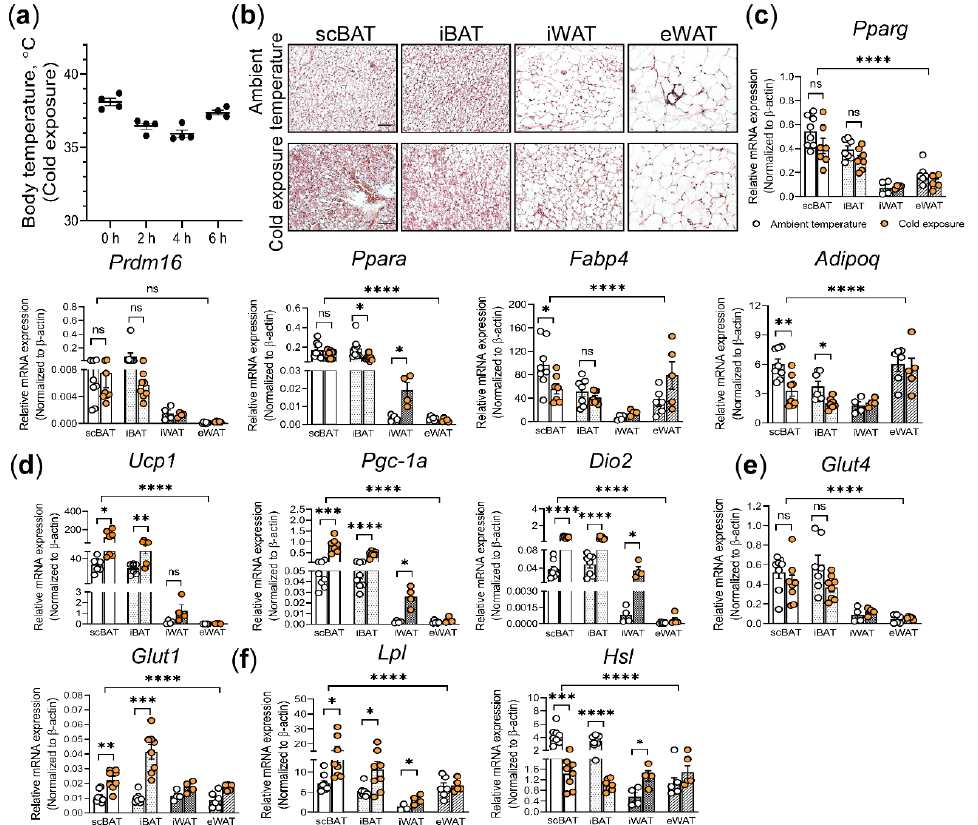
Figure 1. The effect of cold exposure on the adipocyte morphology and gene expression in scBAT, iBAT, iWAT, and eWAT. ( a ) The body temperatures of male C57BL/6 mice undergoing cold exposure (4 ◦ C). n = 4. h: hour. ( b ) Representative images of the H&E stained sections of scBAT, iBAT, iWAT, and eWAT isolated from mice housed for 6 h at ambient temperature (22 ◦ C) or exposed to cold (4 ◦ C). n = 3. Scale bar = 50 µ m. ( c–f ) RT-qPCR analysis of adipocyte differentiation marker genes, thermogenic genes, glucose uptake genes and lipid processing genes in scBAT, iBAT, iWAT, and eWAT depots from mice housed at ambient temperature and under acute cold exposure (4 ◦ C for 6 h). ( c ) Adipocyte differentiation markers, Pparg , Prdm16 , Fabp4 , and Adipoq . ( d ) Thermogenic genes, Ucp1 , Pgc-1 α , and Dio2 . ( e ) Glucose transporters, Glut4 and Glut1 . ( f ) Lipid uptake and processing genes, Lpl and Hsl . The expression of these genes is normalized to the housekeeping gene β -actin. Data are presented as mean ± SEM. n = 4–8 for each group. * p < 0.05, ** p < 0.01, *** p < 0.001, **** p < 0.0001, ns =